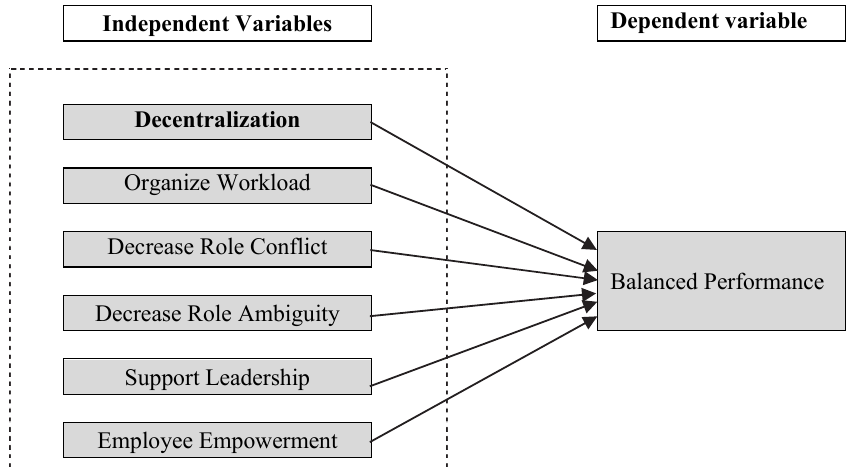
Fig. 1. Study Model (Pantazoglou et al., 2015; Chakraborty & Mukhopadhyay, 2014; Farzanegan et al.,